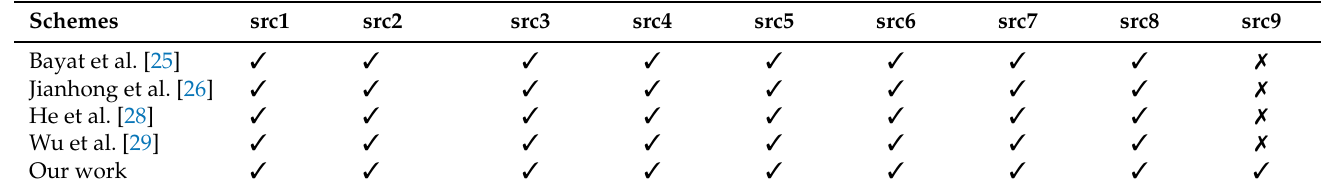
Table 2. Security comparison.